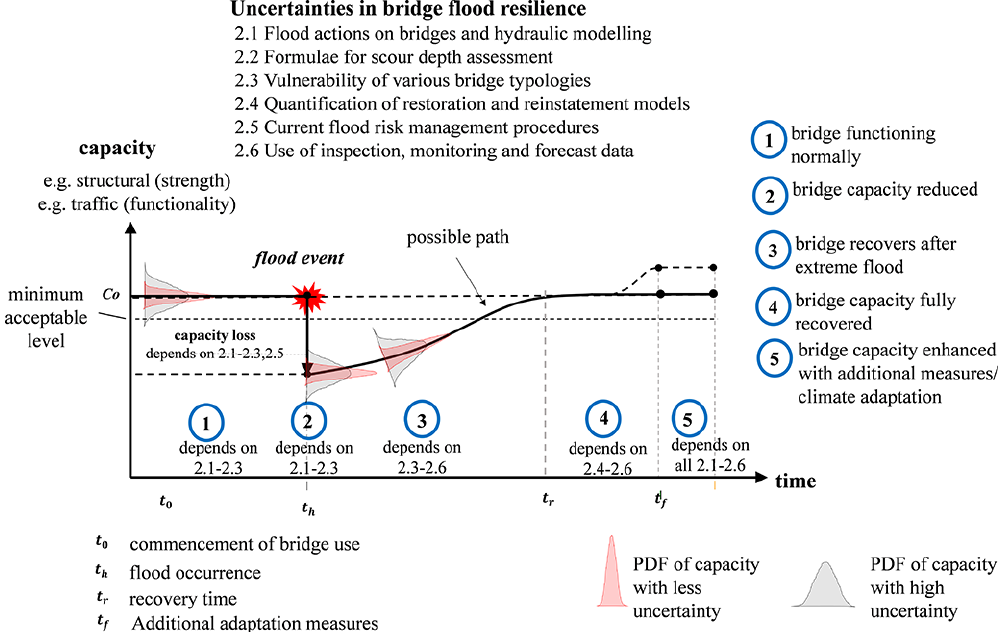
Figure 6. Contribution of uncertainties in hazard, vulnerability, and emergency and post-emergency management to resilience. PDF: proba- bility density